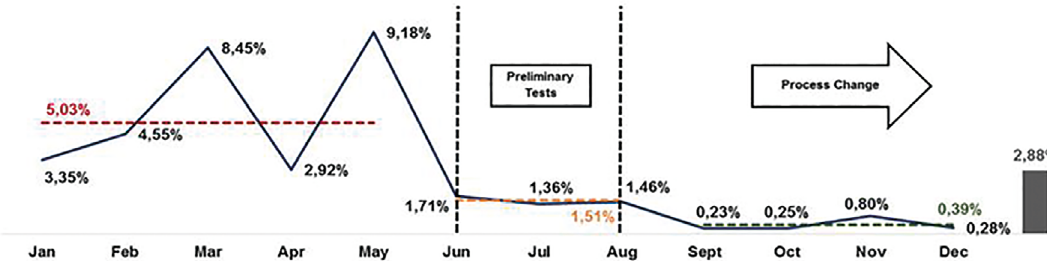
Figure 9. Comparative data of industrial rejection indexes measured for plates manufactured according to A1 condition (Jan-Jun) and according to the new proposed B2 condition (Jun-Dec)